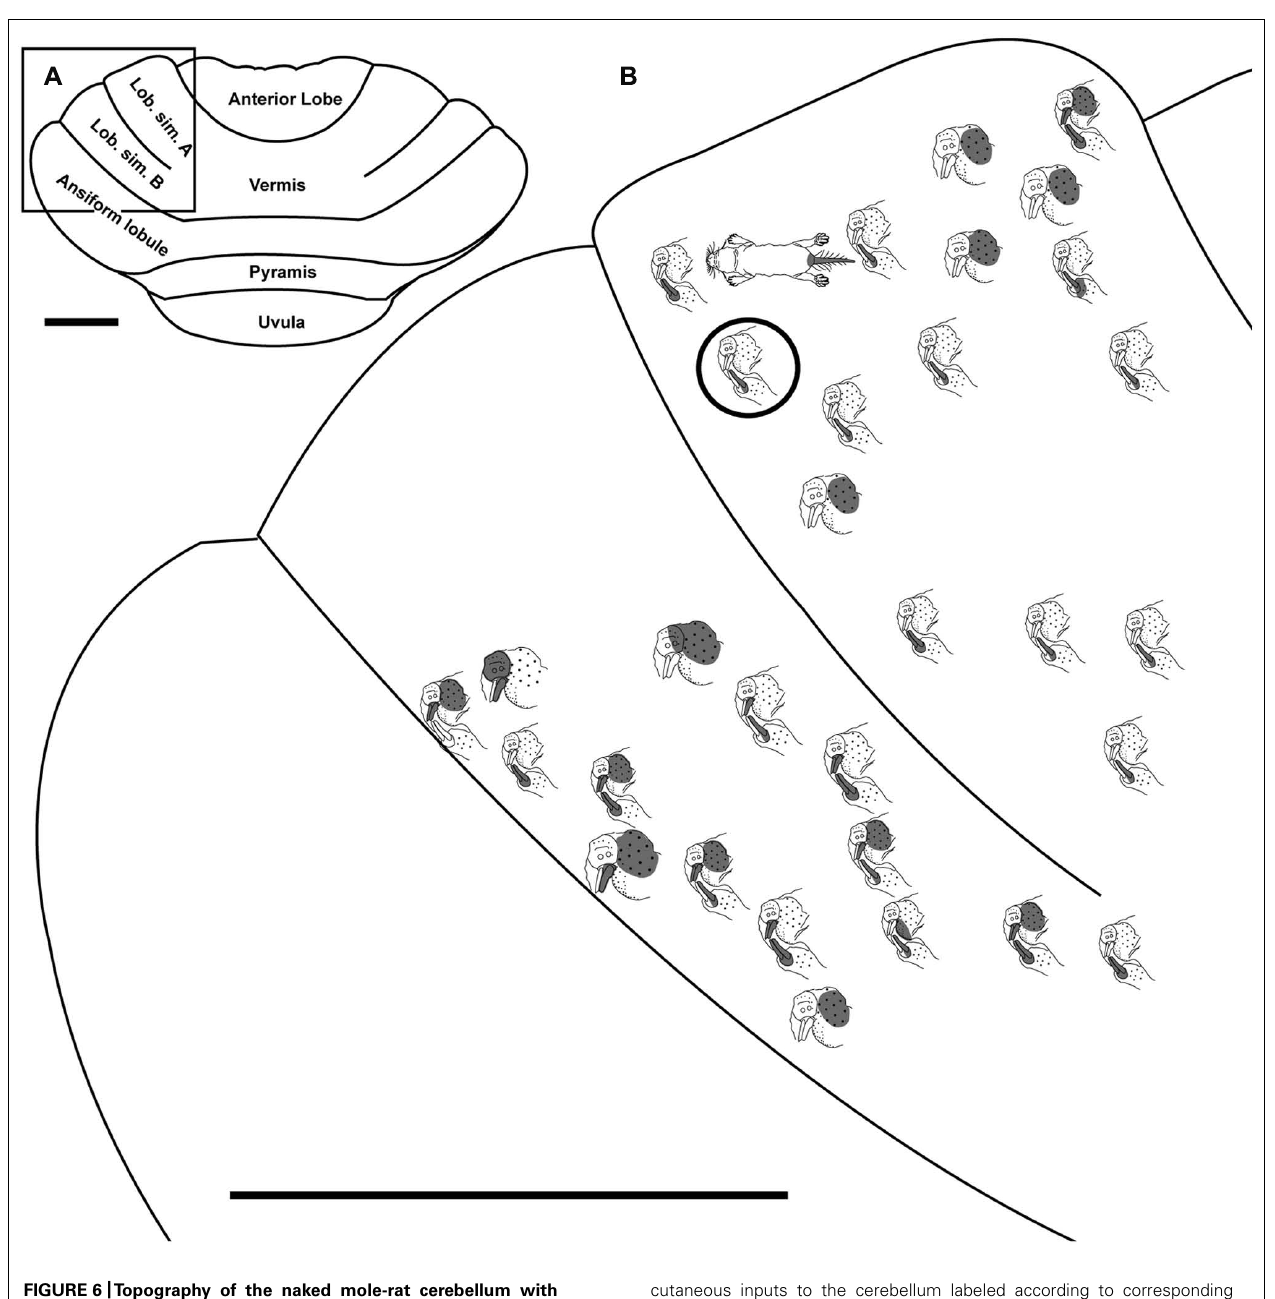
cutaneous inputs to the cerebellum labeled according to corresponding receptive fields. Dark circle outlines a recording site injected with toluidine blue to serve as an anatomical landmark following termination of the experiment. Dorsal view, rostral is up. Animal #050109. Scale bars: 1 mm for both (A,B)